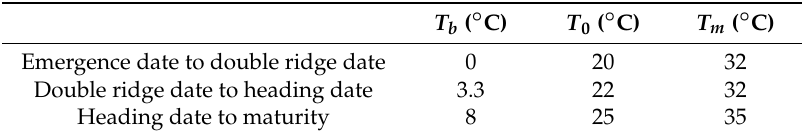
Table A1. The parameters of thermal effect for winter